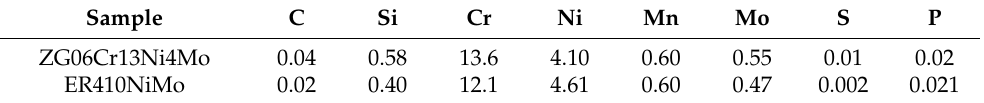
Figure 1. ( a ) Test plate groove; ( b ) sampling diagram; ( c ) twice repair welding specimen; ( d ) tensile and impact specimens. Table 1. Chemical compositions of ZG06Cr13Ni4Mo cast steel and ER410NiMo (mass fraction, wt.%).